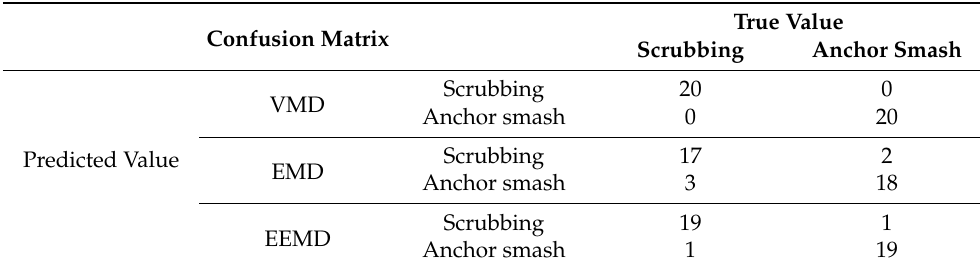
Table 3. The VMD, EMD, and EEMD confusion matrix analysis table.